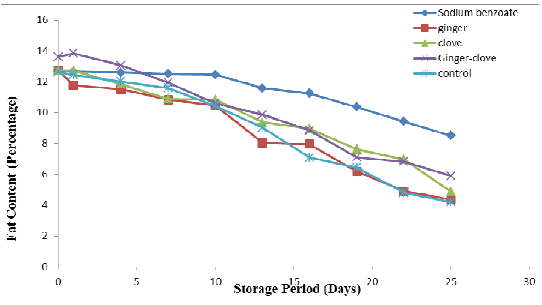
Fig. 16. Effects of various treatments on the titrable acidity of soymilk samples at 1% concentration stored at refrigerated temperature for 25 days